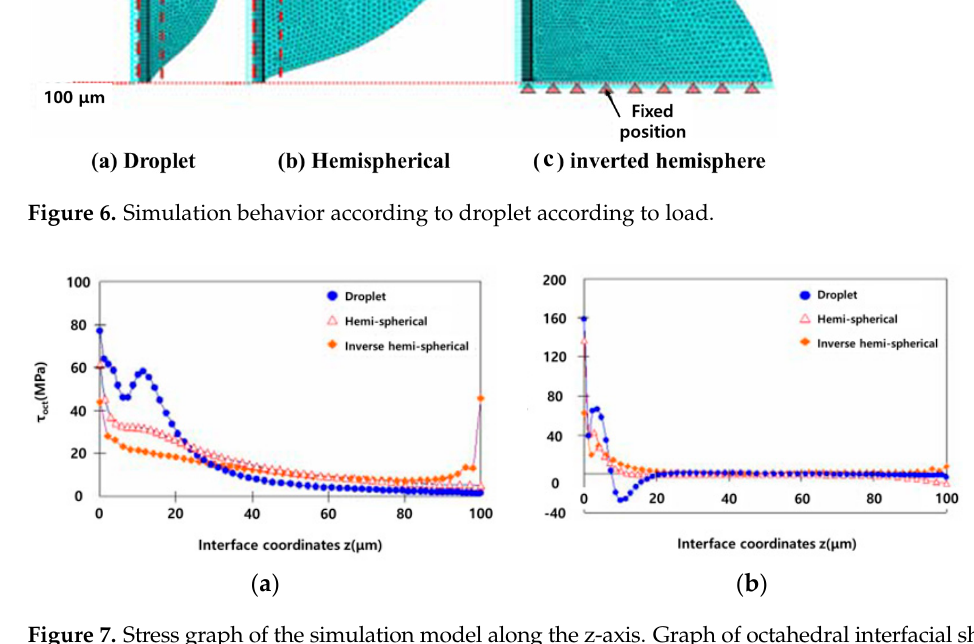
Figure 7. Stress graph of the simulation model along the z-axis. Graph of octahedral interfacial shear stress ( a ) τ oct distribution and ( b ) angle of finite element numerical analysis models of three specimens. The pressure was applied in the direction of the central axis of the fiber at the 10 µ m area of the x -axis, where the tensile stress was converted into the compressive stress, thereby suppressing the interfacial fracture of the droplet specimen (Figure